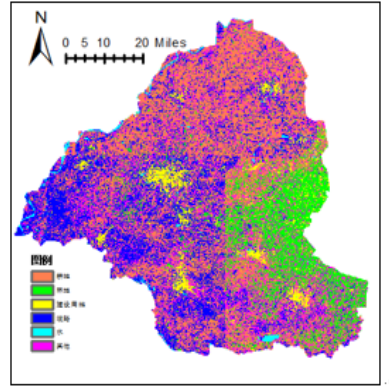
Figure 5 ． Result of ISODATA